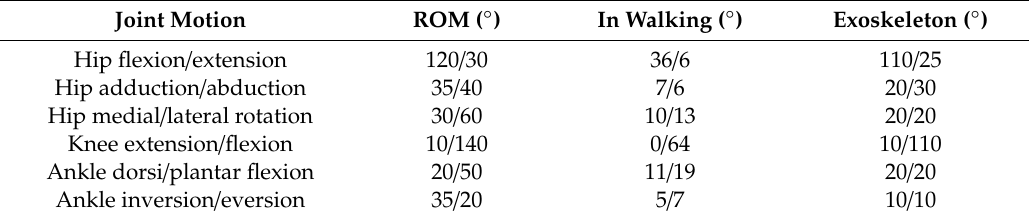
Table 1. Joint ranges of motion of a human and the exoskeleton.